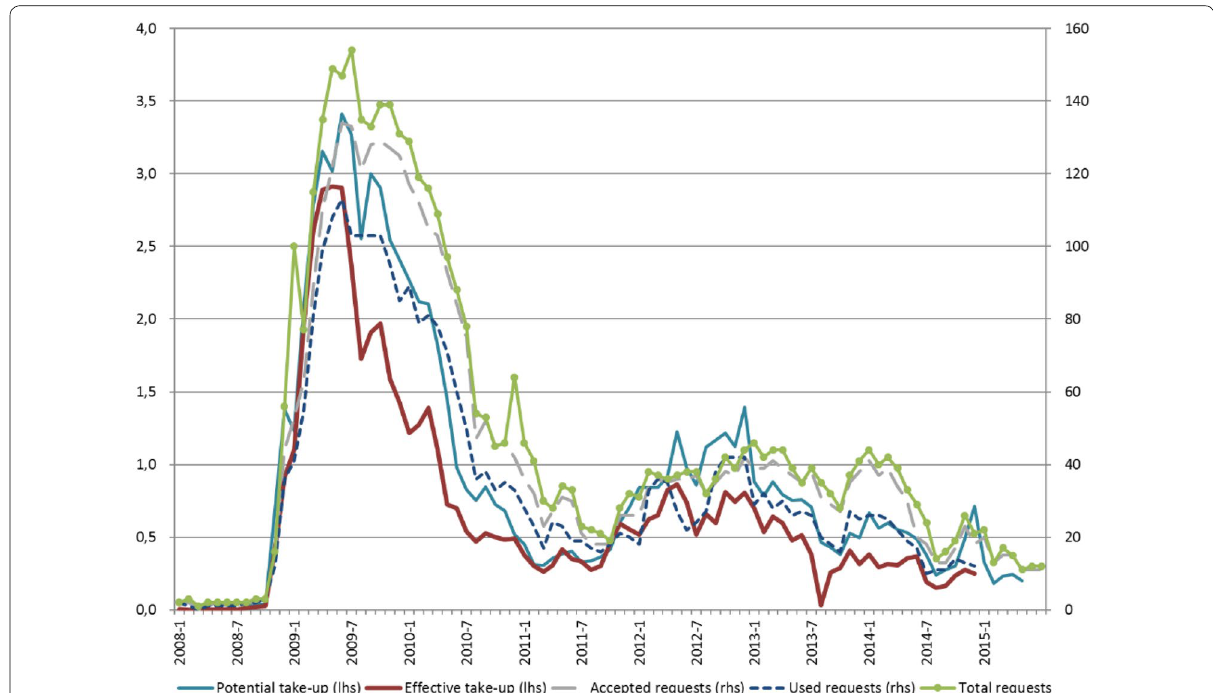
Fig. 1 Participation in short-time work (left-hand scale: as a percentage of total employees, right-hand scale: absolute number of firms) (source: Comité de conjoncture , own